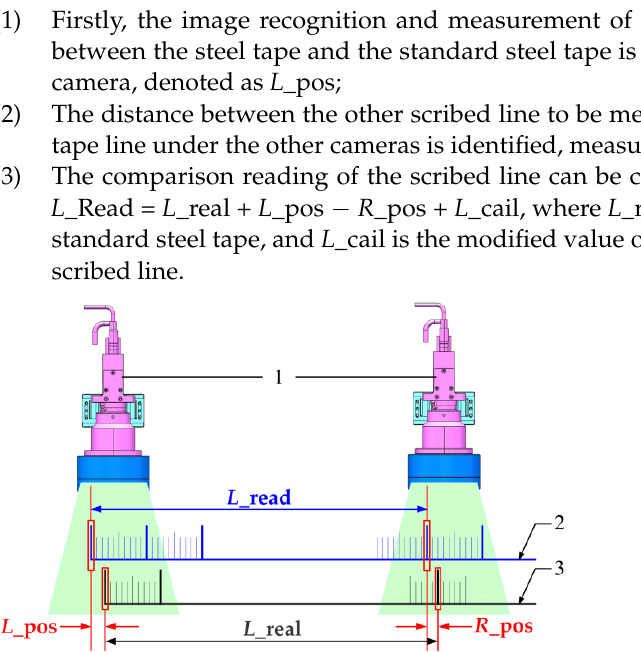
Figure 8. Calibration algorithm for display error: 1. Industrial camera (CCD camera); 2. steel tape; 3. standard steel tape.